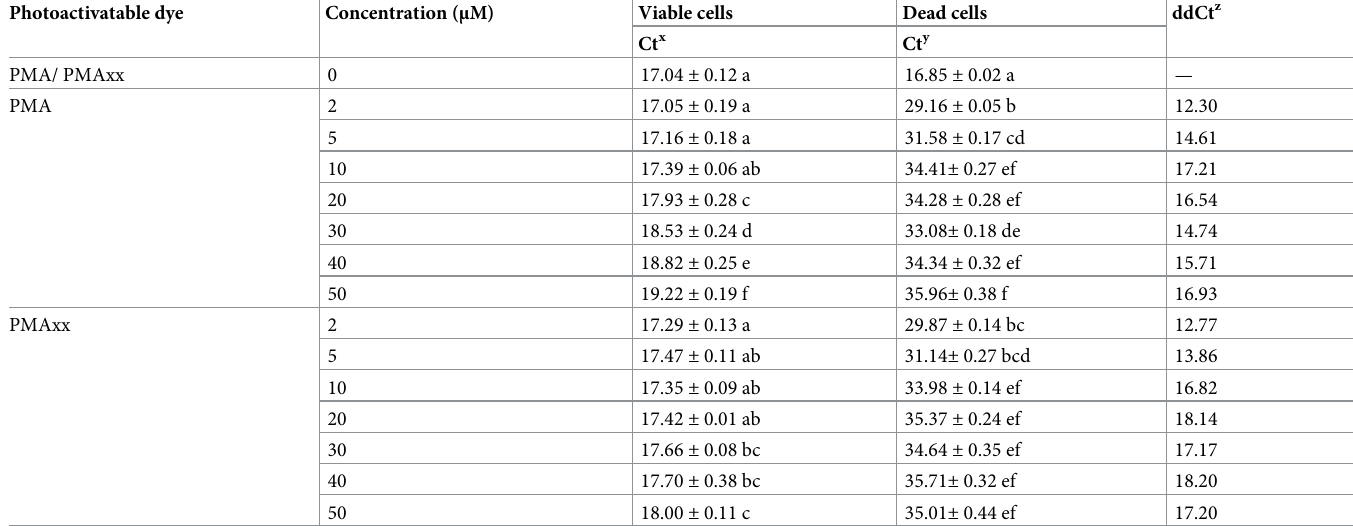
Table 1. Cycle threshold (Ct) of quantitative real-time polymerase chain reaction for the detection of Clavibacter michiganensis subsp. michiganensis (10 7 CFU mL -1 ) treated with propidium monoazide (PMA) and PMAxx (an improved PMA). Photoactivatable